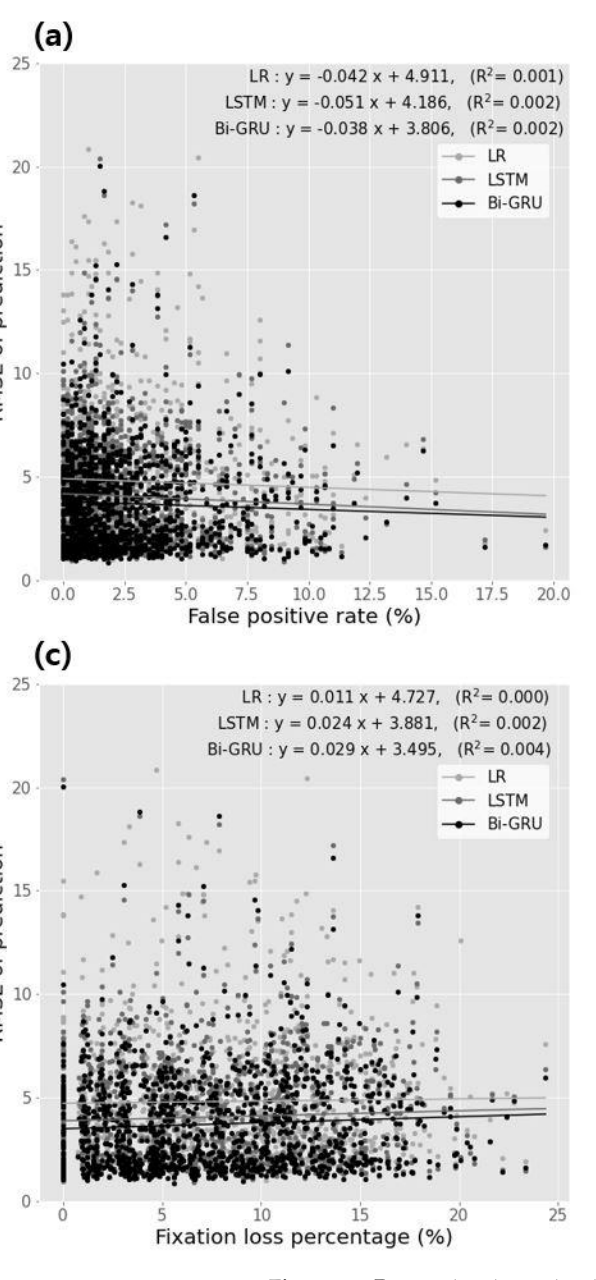
Figure 8. Regression investigation of classification error (MSE) and other parameters. ( a ) MSE correlation with false positive rate. ( b ) MSE correlation with false negative rate. ( c ) MSE correlation with loss function value. ( d ) MSE correlation with visual field mean deviation (D).